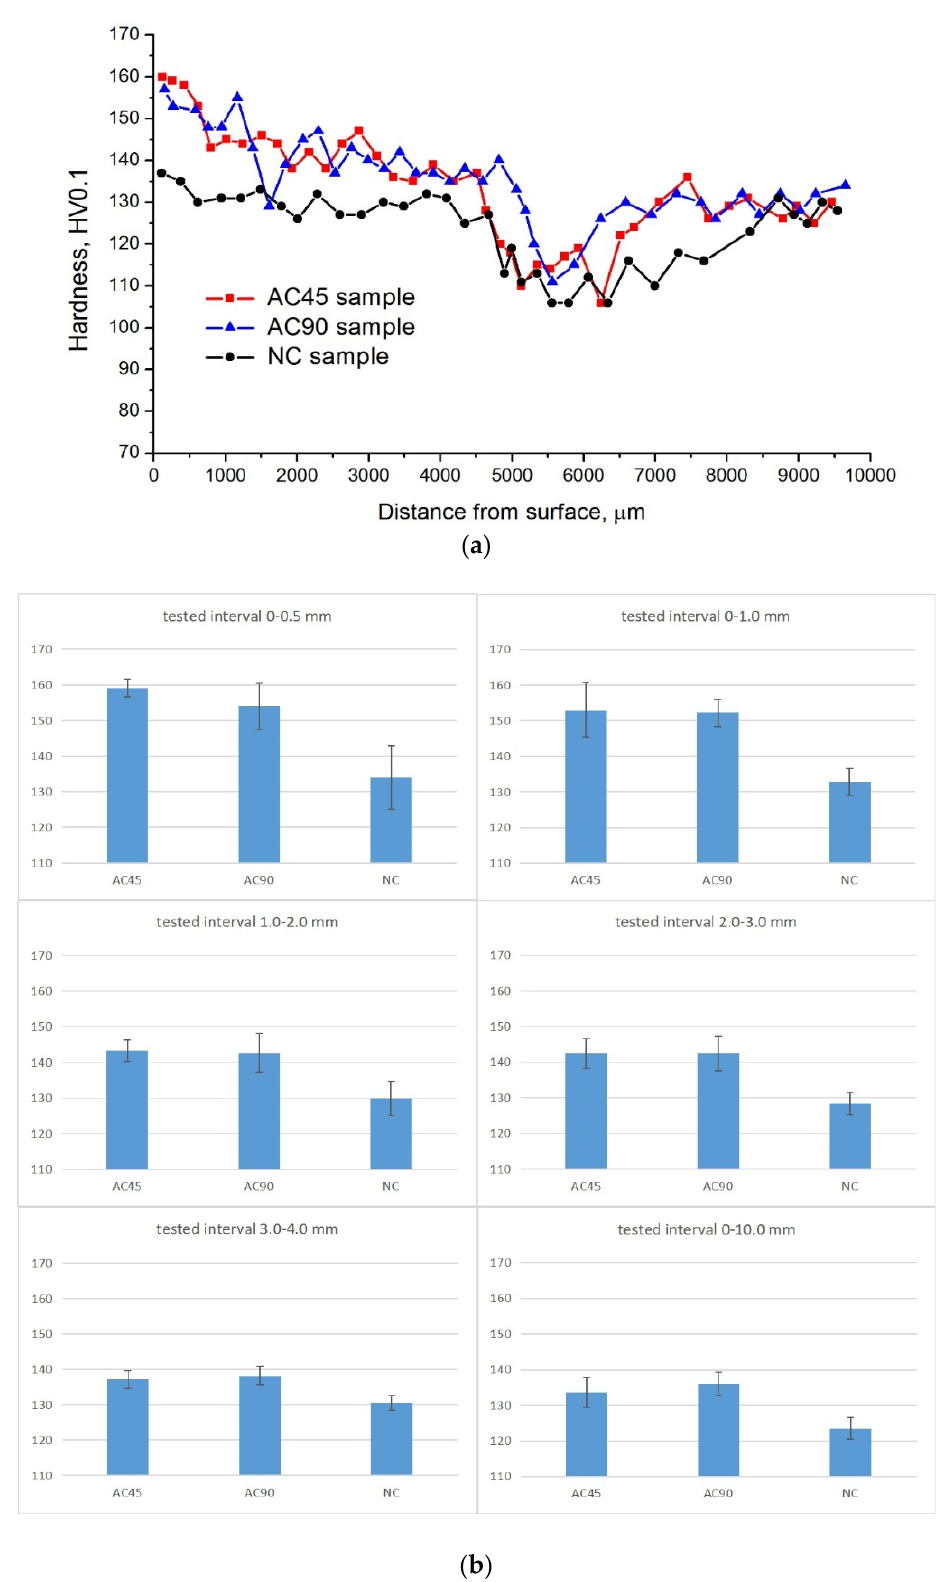
Figure 13, and in Table 6, the average value of hardness as a function of the distance from the processed surface along with the variability range of the examined parameter.